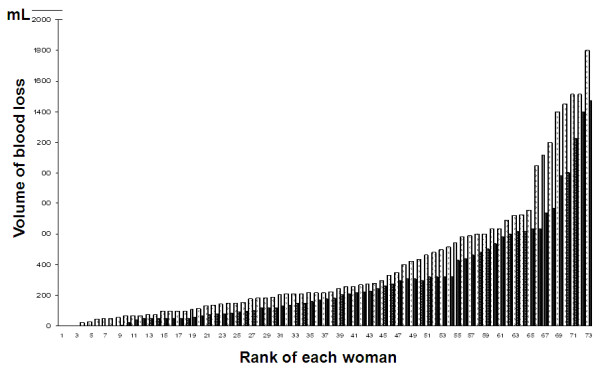
Bar graph illustrating blood loss between T1 and T4 (from the smallest to the largest) for each woman in the two groups. Black bars = TA group, white bars = control group. The y-axis represents the volume of blood loss (in millilitres) between T1 and T4. The x-axis values are the rank of each woman according to the amount of blood loss.